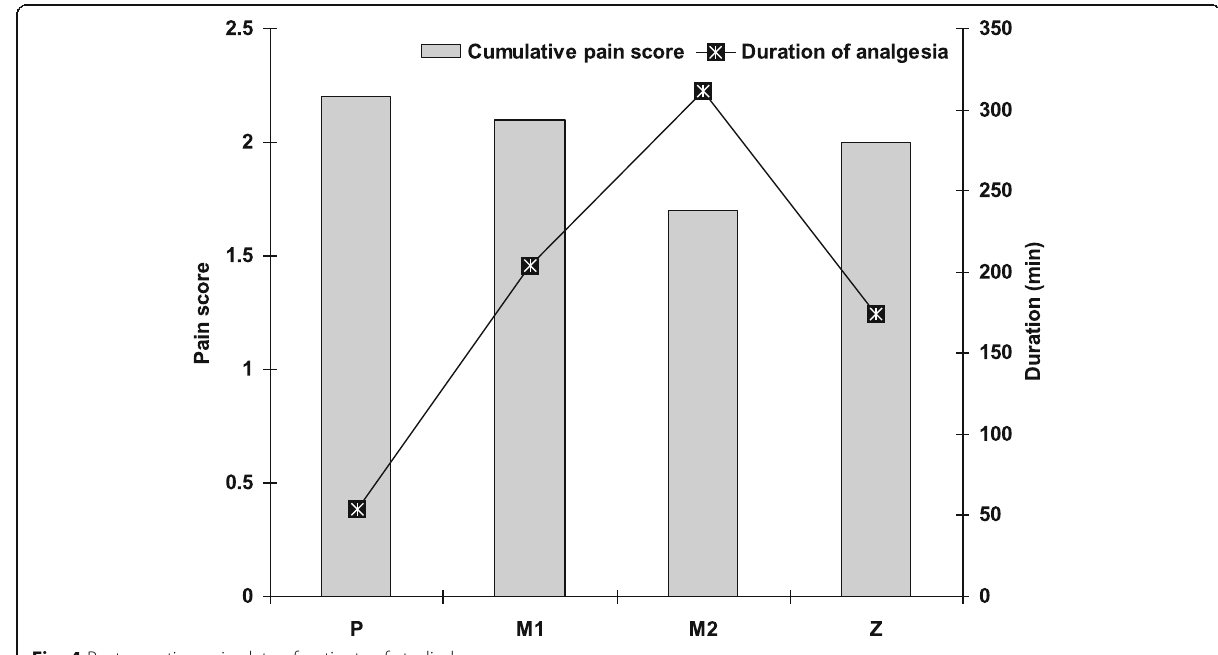
Fig. 4 Postoperative pain data of patients of studied groups